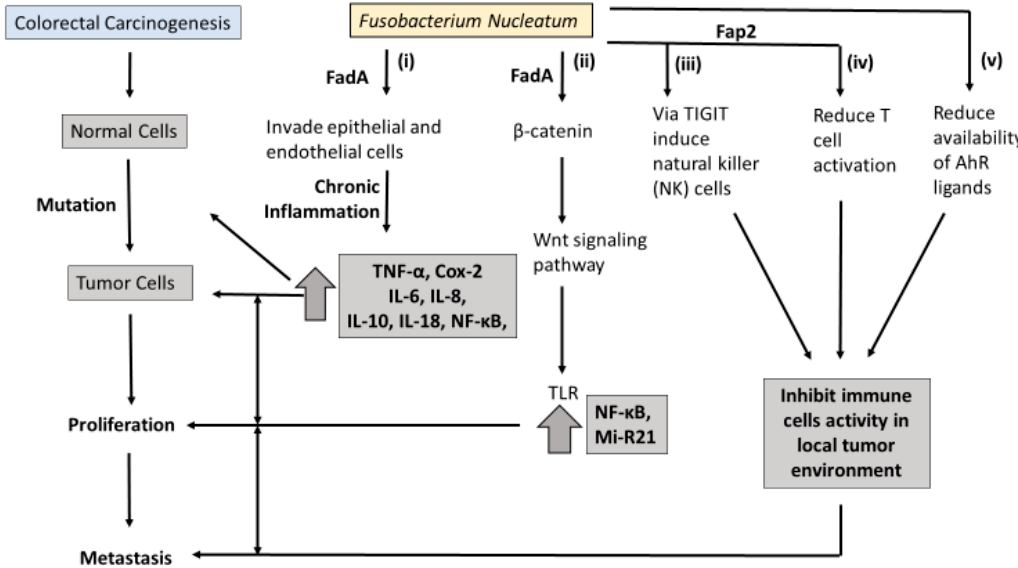
Figure 1. Summary of five hypothetical pathways of Fusobacterium nucleatum (Fn) in promoting colorectal carcinogenesis: (i) FadA in Fn promotes chronic Fn infection of colon mucosa that triggers reactive oxygen species (ROS) and proinflammtory mediators; (ii) Fad2 activates β - catenin signaling that, through the Wnt signaling pathway, results in increased miRNA and NF- κ B, and ultimately increases tumor proliferation; (iii) Fap2 interacts with TIGIT on natural killer (NK) and T cells to suppress immune response and promote tumor growth; (iv) Fn through Fap2 may recruit tumor-infiltrating myeloid cells; (v) Fn in conjunction with other microbiota may affect the production of Aryl hydrocarbon receptor (AhR) ligands. AhR mediates the transcription of cytokines that regulate immune response and immune-response inhibition promotes tumor growth.